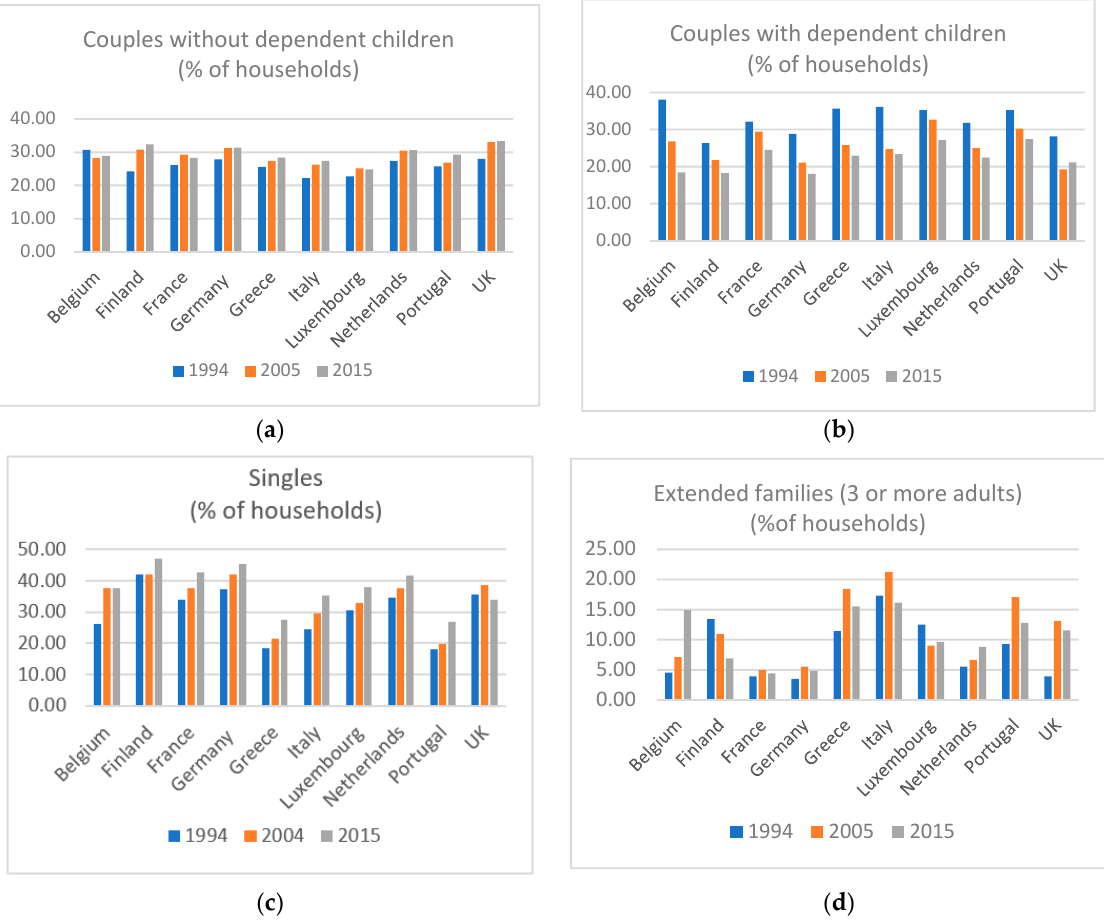
Figure 5. Source: our elaboration on Eurostat data. ( a ) Time changes—Couples without dependent children (% of households); ( b ) Time changes—Couples with dependent children; ( c ) Time changes—Single (% of households); ( d ) Time changes—Extended families (3 or more adults; % of households).